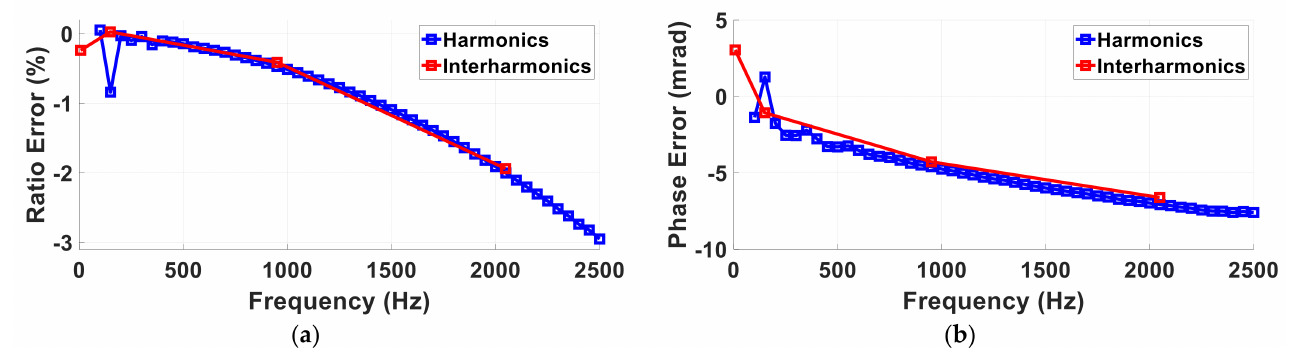
Figure 6. Ratio ( a ) and phase ( b ) errors of VT under test in FTN conditions with harmonic components (circle markers) and interharmonic components (square markers).